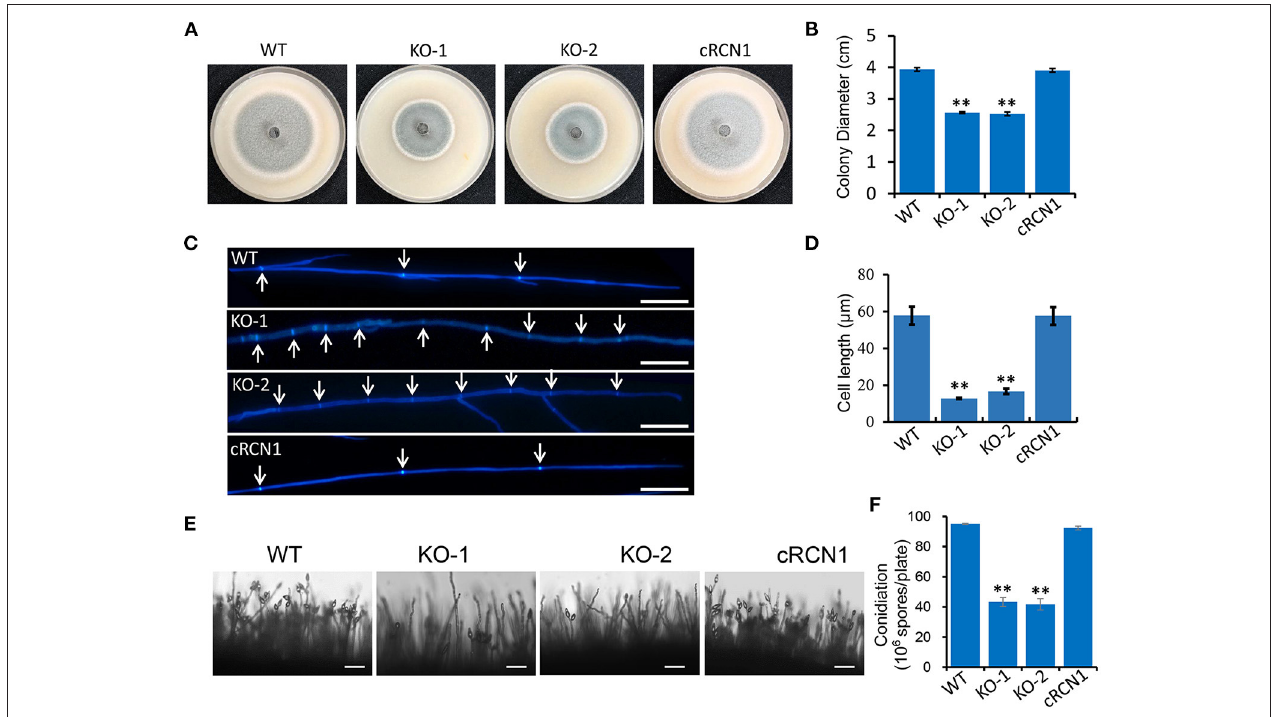
FIGURE 1 | MoRCN1 is involved in vegetative growth. (A) Colony morphology of the wild-type P131, 1 Morcn1 mutants, and complemented strains were observed on oatmeal tomato agar (OTA) plates at 28 ◦ C for 5 days. (B) The colony diameters were measured and subjected to statistical analysis. Error bars represent standard deviation, and asterisk represents significant differences ( P < 0.01). (C) Hyphal tips of the wild-type P131, 1 Morcn1 mutants, and complemented strains. The arrows indicate septa between cells. Bar 20 µ m. (D) Cell length of the apical and subapical cells in the hyphae tips of strains in (C) . Means ± SD were calculated from three independent experiments. Significant differences compared to the wild type (WT) are indicated by an asterisk ( P < 0.01). (E) Conidial and conidiophore formation were observed under a light microscope. The indicated strains were grown on OTA plates for 5 days. Bar 50 µ m. (F) Statistical analysis of conidiation of the wild type, 1 Morcn1 mutants, and complemented strains. Error bars represent the standard deviation, and asterisks represent significant differences ( P <